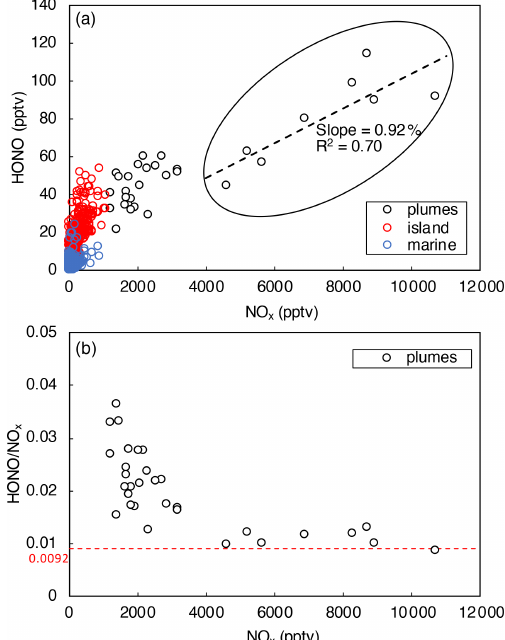
Figure 5. HONO concentrations plotted against NO x concentration during daytime from 10:00 to 15:00. Data were divided into three categories (i.e., polluted plumes, island-influenced air, and clean marine air) based on local wind direction and NO 2 concentrations. The dashed black line in (a) represents the best fits of linear regres- sion between HONO and NO x in polluted plumes (0 < wind direc- tion < 180 ◦ , [NO x ] > 4ppbv). The dashed red line in (b) indicates where HONO / NO x = 0 .